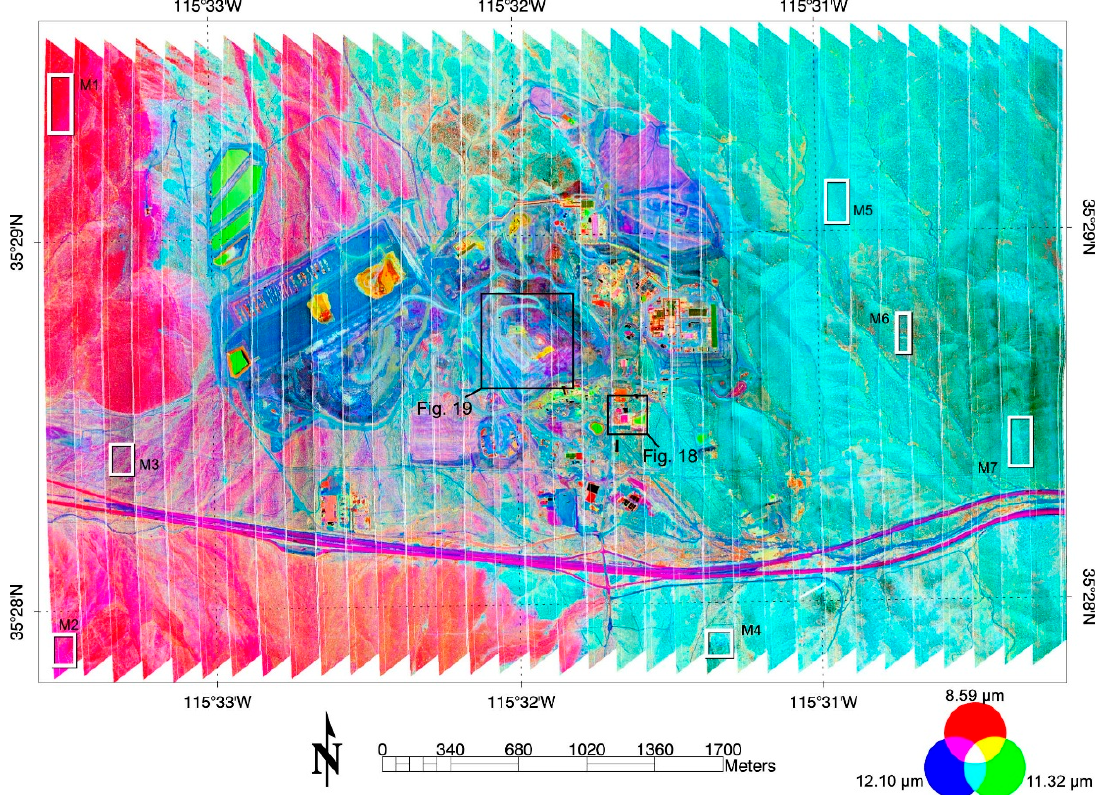
Figure 16. False color composite mosaic of the Mako emissivity data with bands 8.59/11.32/12.10 µm displayed in red/green/blue. The white boxes outline regions of interest discussed in the text and Figure 17. The black boxes outline the data subsets shown in Figures 18 and 19.